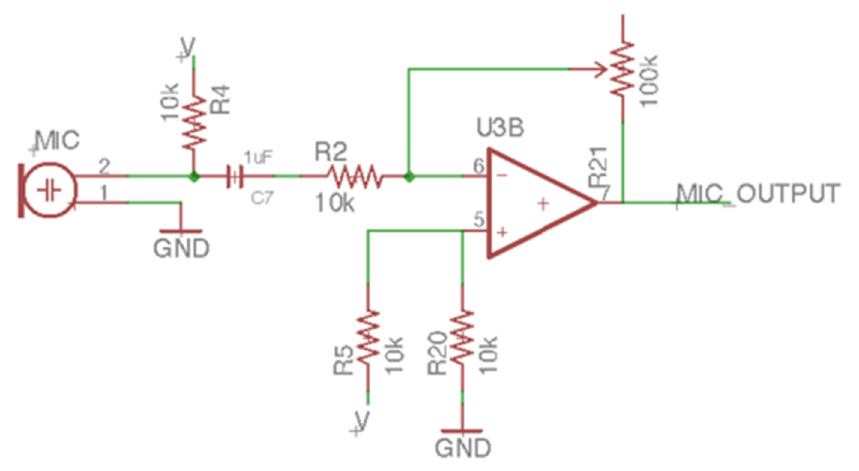
Figure 9. The microphone circuit of the laser audio transmission device.